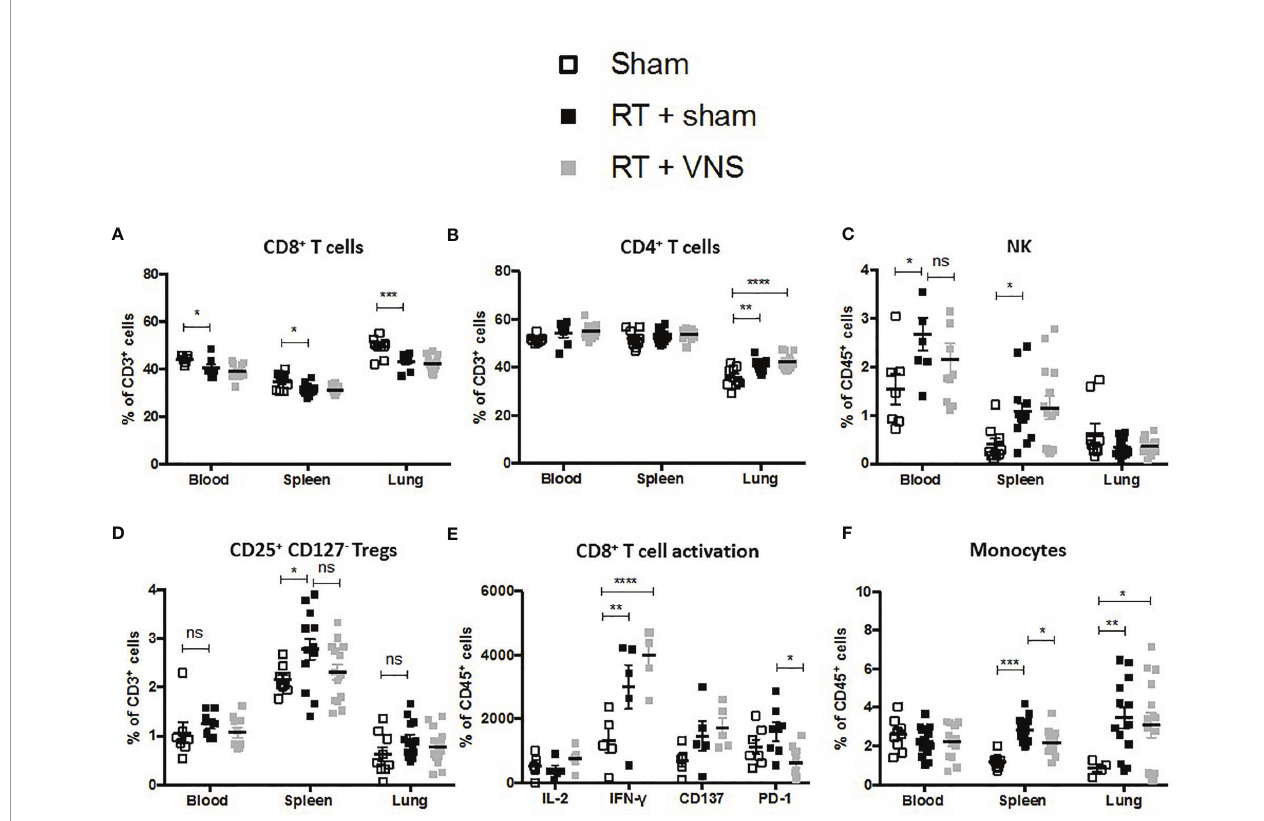
FIGURE 2 | Evaluation of immune cell populations in lung tumor bearing mice treated with RT+VNS. Flow cytometric analysis of lymphoid (A) CD8 + T cells, (B) CD4 + T cells, (C) CD56 + NK cells, (D) CD4 + CD25 + CD127 - Tregs in blood spleen and lung TME. (E) Cell suspensions from murine lung tissue were co-cultured with LLC cells at ratio 10:1 in vitro . After 24 hours, CD8 + TIL expression of the function markers IL-2, IFN- g , CD137 (4-1BB) and PD-1 was assessed via fl ow cytometry. (F) Flow cytometric analysis of myeloid CD11b + Ly6C + monocytes in blood spleen and lung TME. Of note, the sham group in this fi gure represents the same group as in . Data represent three pooled experiments six days after the last treatment. Data are shown as mean ± SD of n=13 (RT) and n=14 (VNS+RT). *P < 0,0332; **0,0021; ***0,0002; ****0,0001 by two-tailed unpaired t-tests. ns, non signi fi